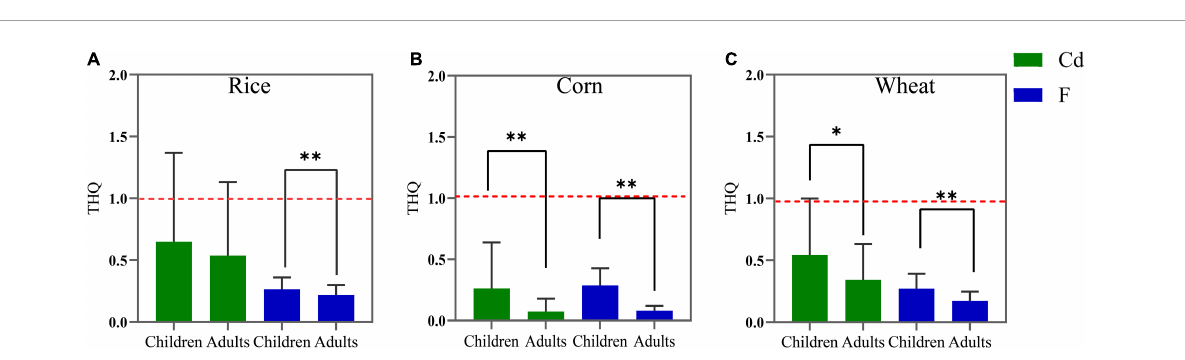
FIGURE5 The target hazard quotients (THQ) values for rice (A) , corn (B) , and wheat (C) grains consumption by children and adults. The red dashed line denotes the limit value of the THQ (1.0). ∗ p < 0.05, ∗∗ p < 0.01.